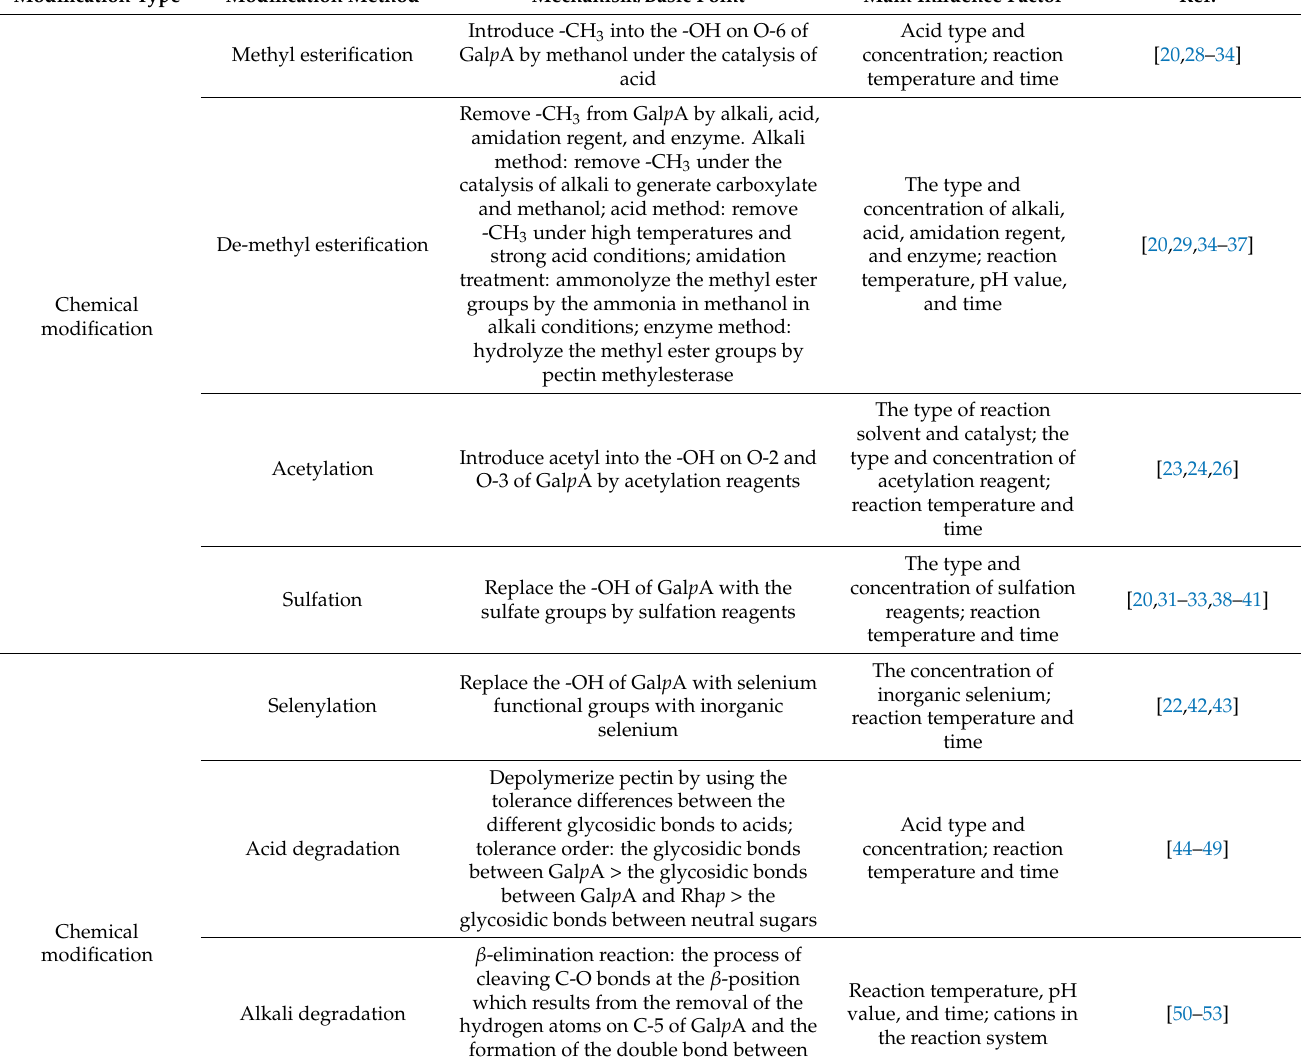
Table 1. Summary of the methods for chemical and physical modifications of